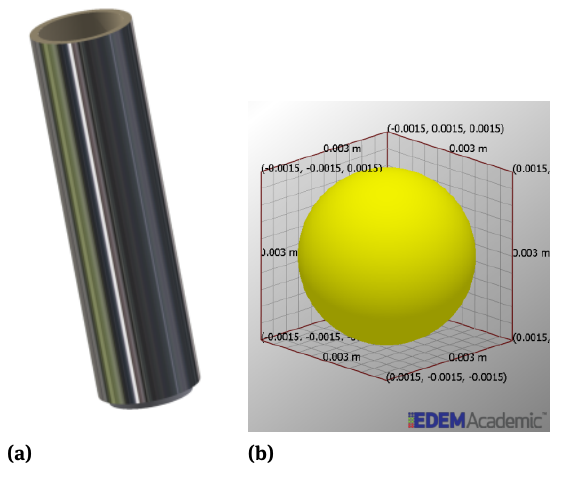
Figure 7: a) 3D model of the storage, b) model of the glass particle Table 3: Input parameters for measuring forces in the EDEM Aca- demic